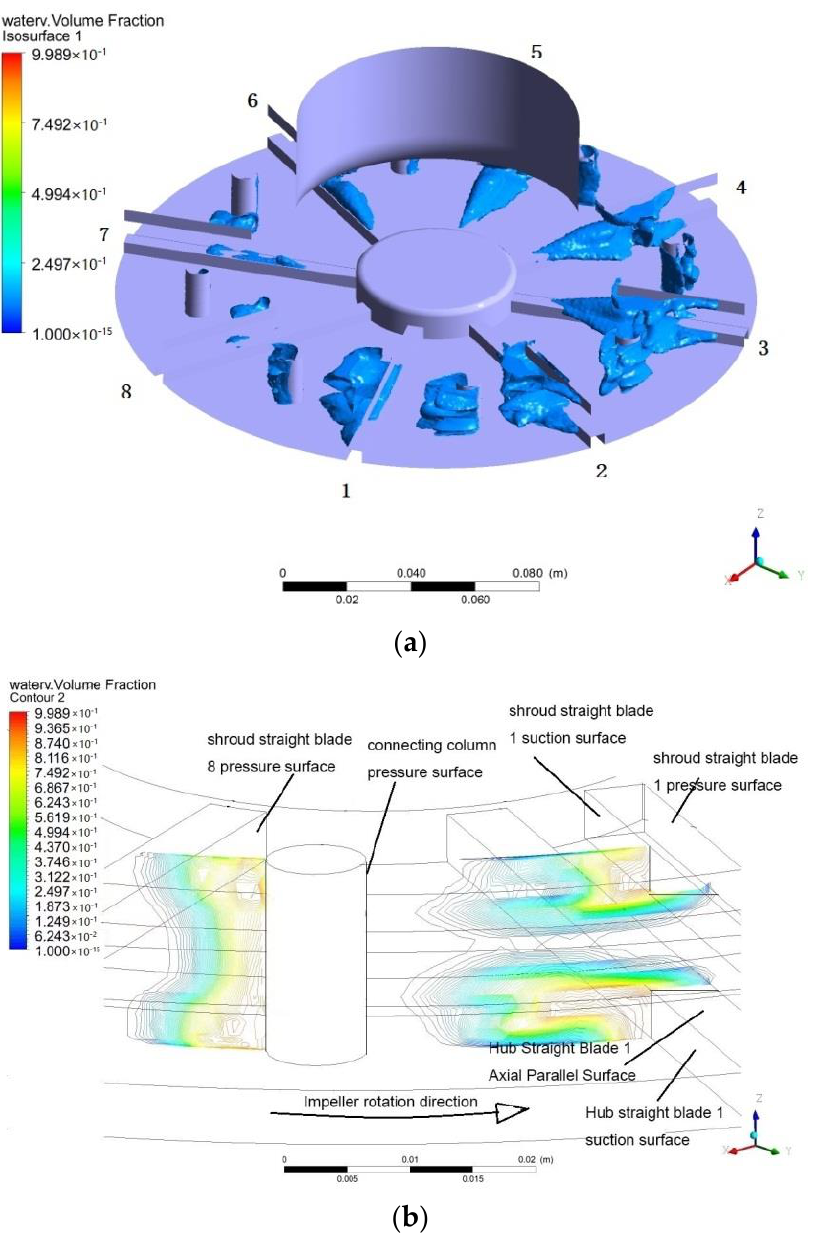
Figure 9. Internal cavitation iso-surface and representative radial cross-section cavitation distribution of the impeller of disc pump (Q d = 80.9 m 3 /h). ( a ) cavitation iso-surface distribution of blade numbers 1 to 8, ( b ) cavitation distribution of a representative radial cross-section